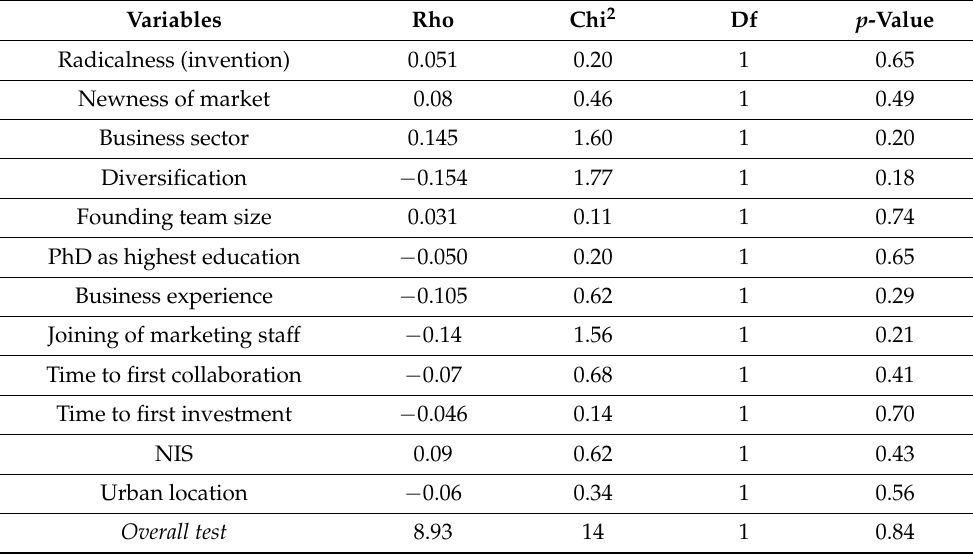
Table A1. Results of proportional-hazards assumption test.